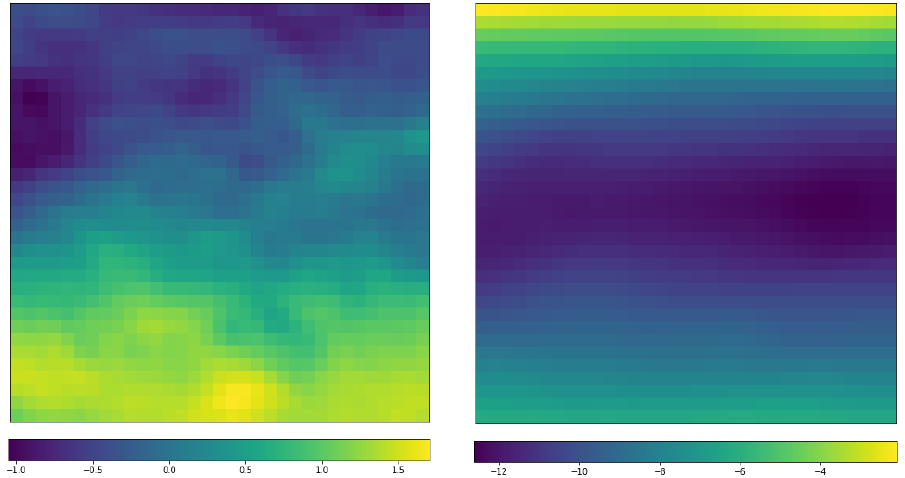
Figure 12. Distribution of mean u-component of wind (u) differences (unit: m/s) between the 584 RI cases and randomly selected 584 non-RI samples at ( left ) 850 hPa and ( right ) 200 hPa. The X-axis and Y-axis are aligned as in Figure 8.